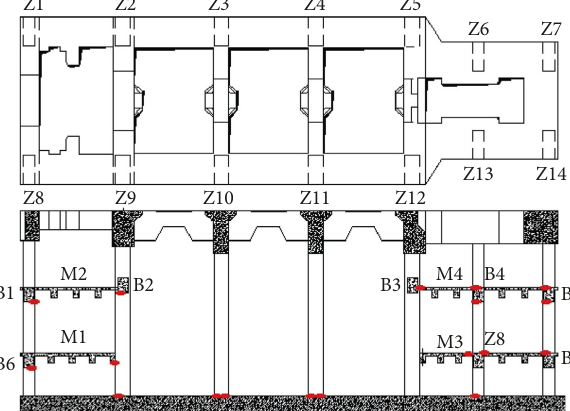
Figure 20: Distribution of main cracks of foundation model.